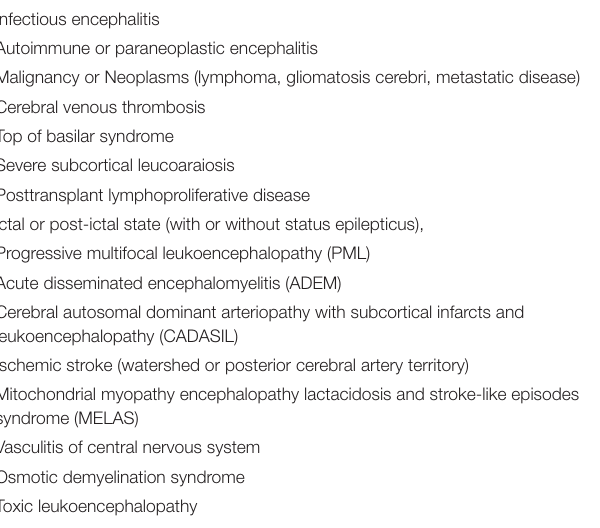
TABLE 3 | Differential diagnoses of posterior reversible encephalopathy syndrome in children. Infectious encephalitis Autoimmune or paraneoplastic encephalitis Cerebral venous thrombosis Top of basilar